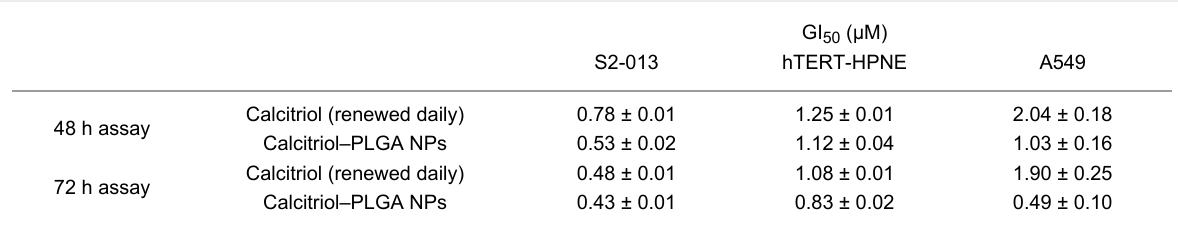
Table 3: Cytotoxic effects of calcitriol on the growth of cell lines, S2-013, hTERT-HPNE and A549, respectively. The results are expressed as GI 50 (the concentration necessary to inhibit cell growth to 50%) at 48 and 72 h of exposure with free calcitriol and entrapped calcitriol in PLGA NPs by SRB assay.